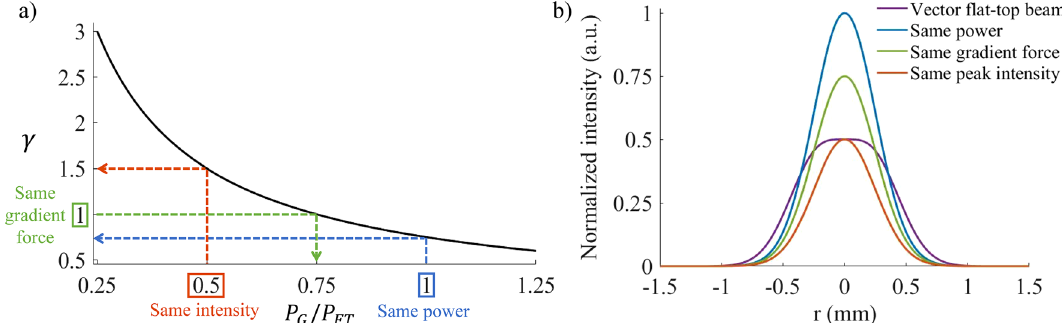
Figure 4. Comparing the gradient force of a Gaussian and vector flat-top beam. ( a ) The relationship between the relative gradient force and power of a Gaussian and vector flat-top beam. ( b ) The intensity profiles corresponding to a Gaussian beam having the same power, gradient force and intensity as a vector flat-top